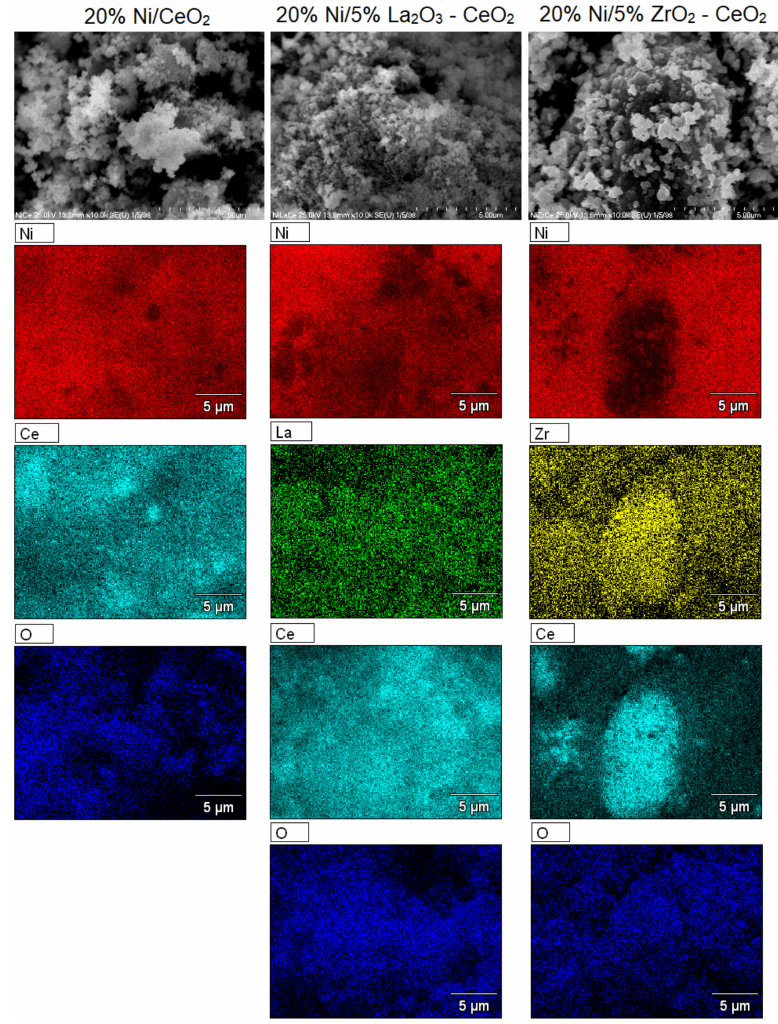
Figure 15. SEM images of 20% Ni/La 2 O 3 , 20% Ni/5% CeO 2 –La 2 O 3 and 20% Ni/5% ZrO 2 –La 2 O 3 catalysts calcined in air atmosphere at 400 ◦ C for 4